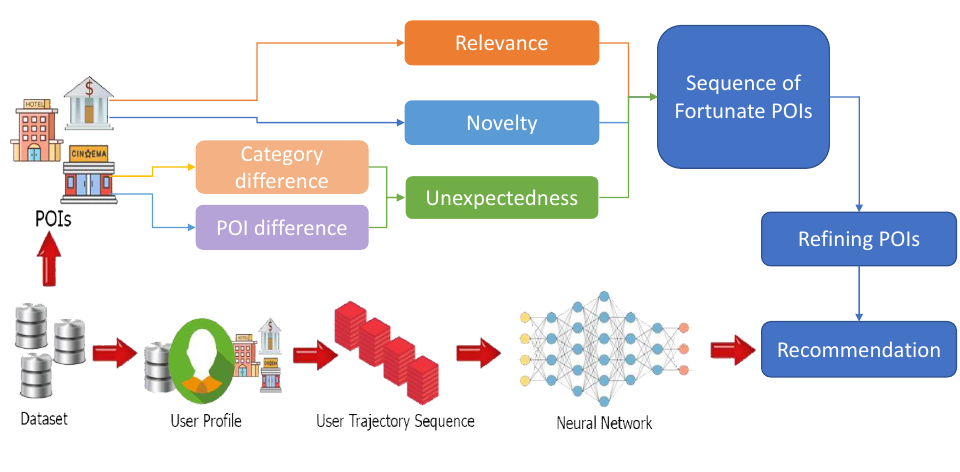
Figure 1. The overview of